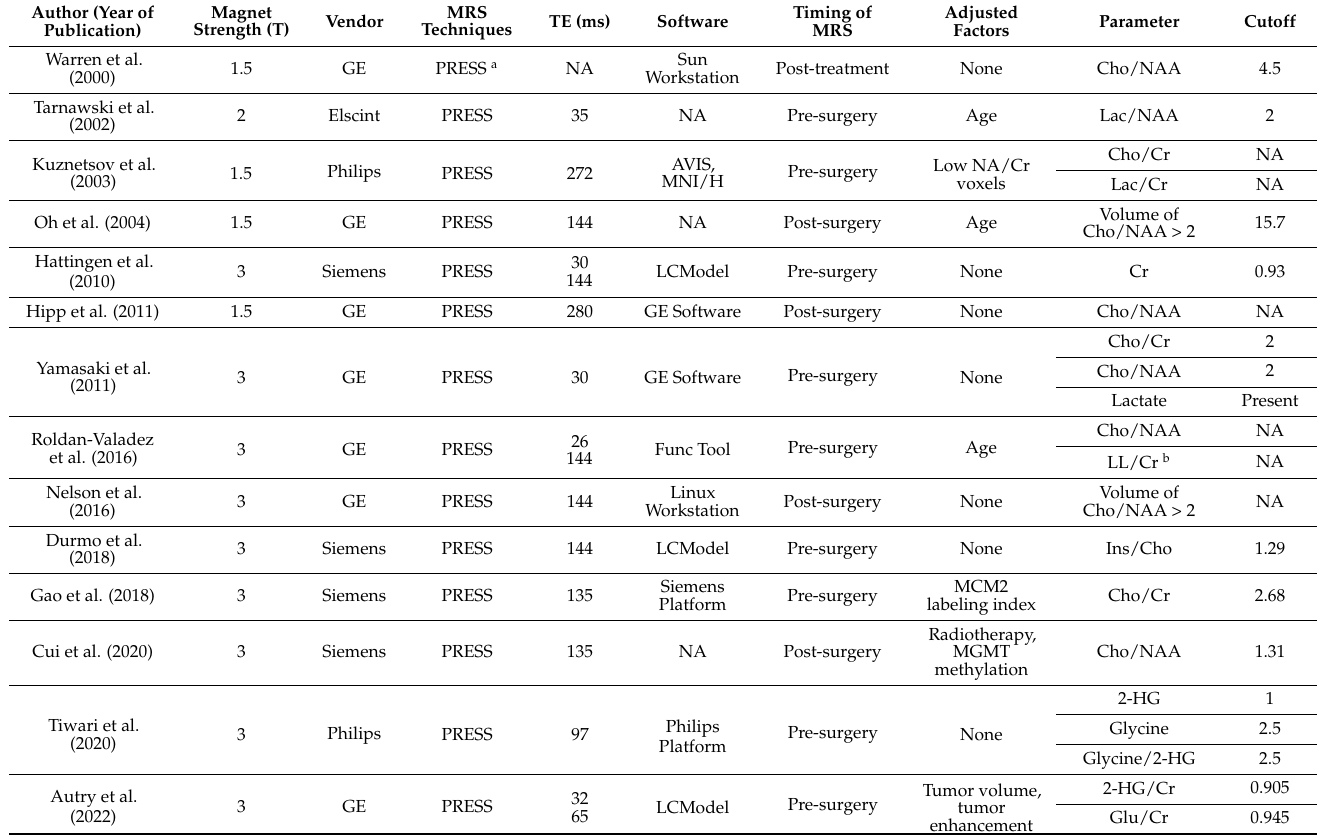
Table 2. MRI and metabolite characteristics of the selected